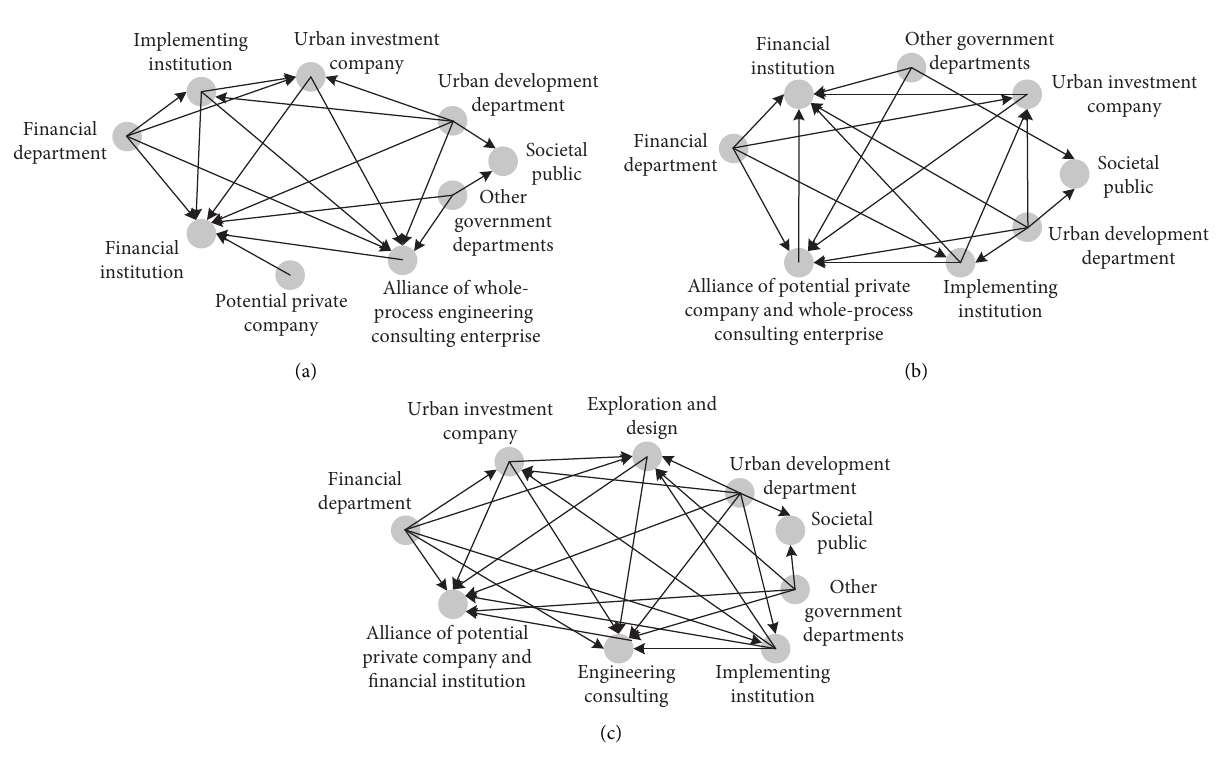
Figure 2: Trust network structure of different alliance strategies. (a) Model 2. (b) Model 3. (c) Model 4. Table 7: Trust network alliance structure